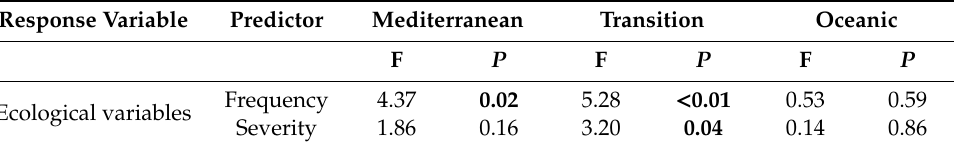
Table 2. Results of the Permutational Multivariate Analysis of Variance (PERMANOVA) [‘ adonis ()’ outputs], showing the e ff ects of the variables fire frequency and burn severity on ecological variables (percentage cover of bare soil, of fine plant debris, and of coarse plant debris; vegetation; and maximum height of living vegetation).